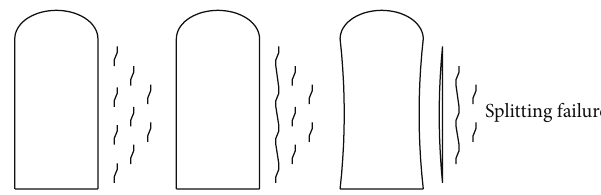
Figure 7: The sketch of splitting failure mode around